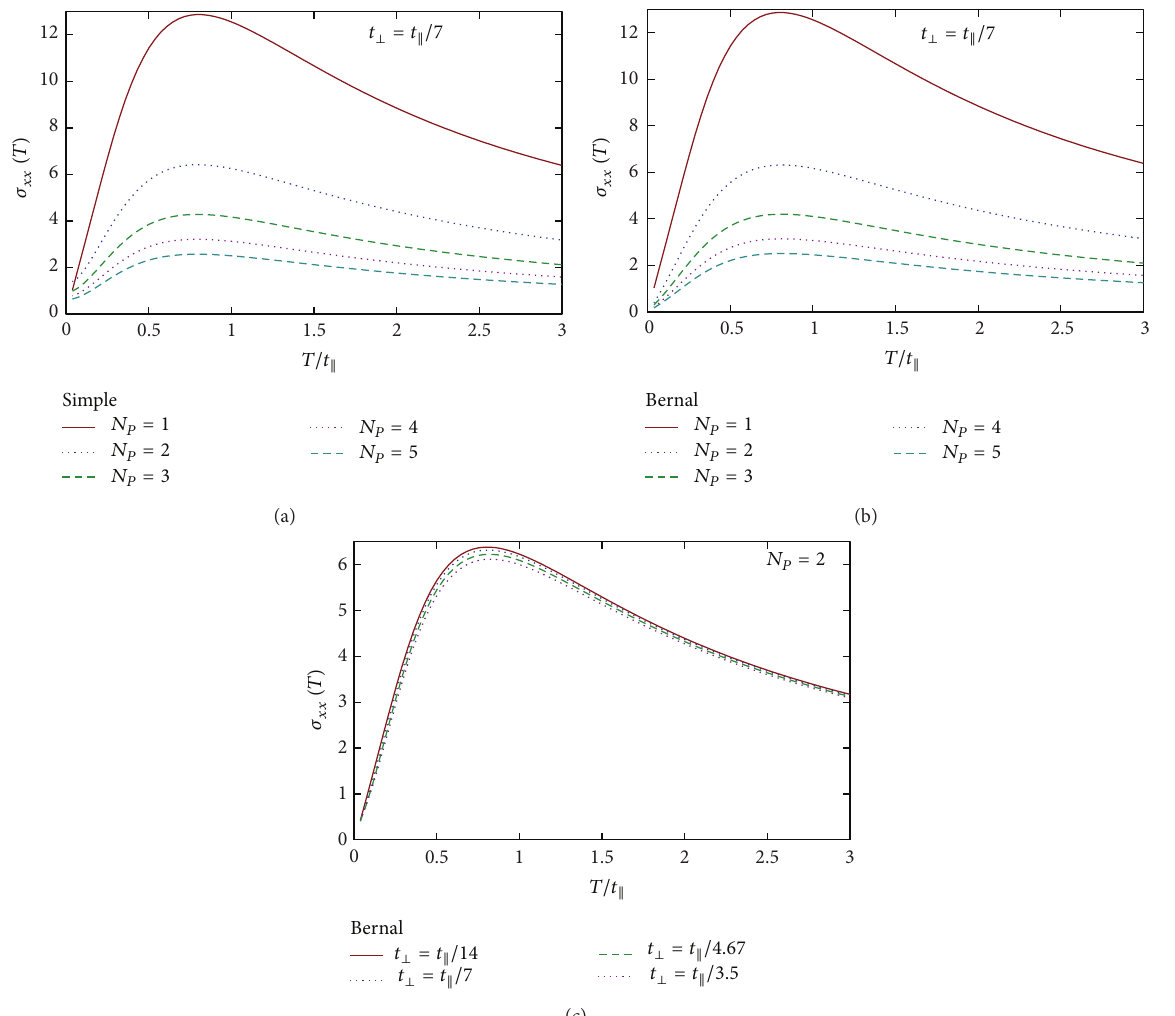
Figure 3: The FEC of mono-, bi-, tri-, tetra-, and pentalayer graphene plane for simple structure (a) and Bernal case (b). In (a) and (b), the interplane hopping term is chosen to be 𝑡 ⊥ = 𝑡 ‖ /7 . (c) shows the FEC of the bilayer Bernal graphene for four values of interplane hopping term, 𝑡 ⊥ = 𝑡 ‖ /14 , 𝑡 ‖ /7 , 𝑡 ‖ /4.67 , and 𝑡 ‖ /3.5 .